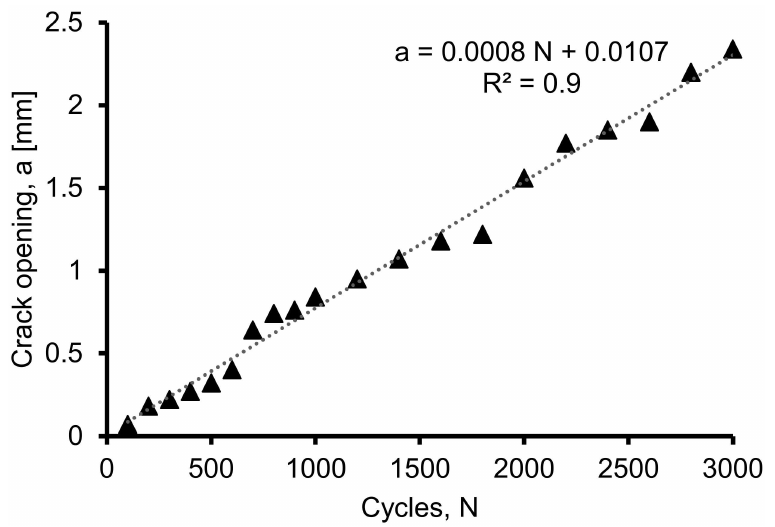
Figure 12. Relationship between crack opening and the load cycles of the beam.